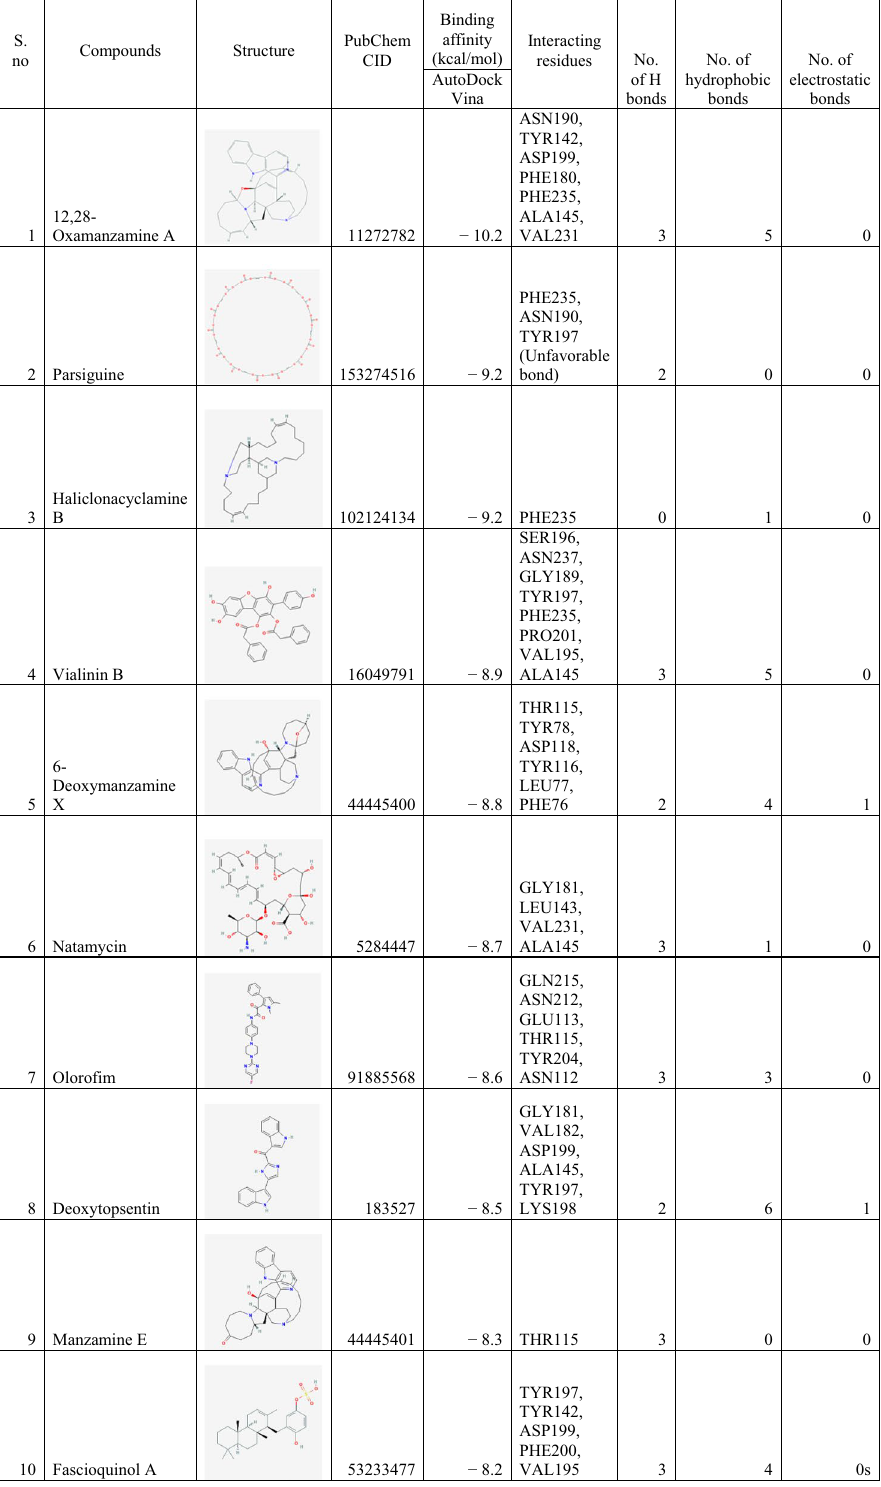
Table 4 The binding affinity and interaction pattern analysis of top 10 ligands docked with CotH3 S. no